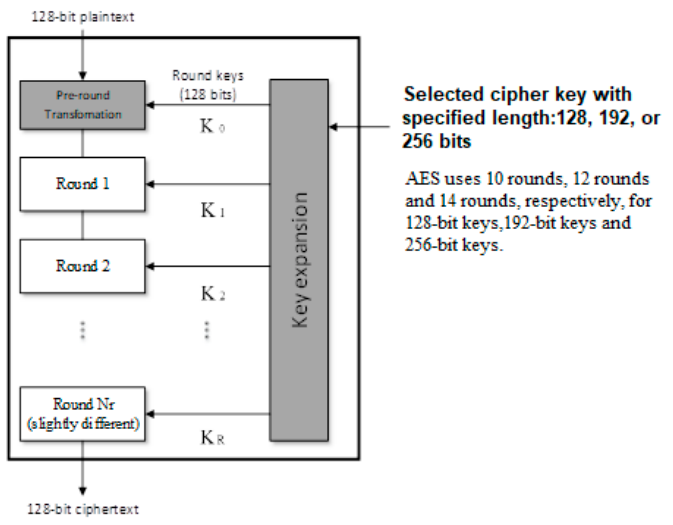
Figure 6. Advanced encryption standard (AES) architecture.